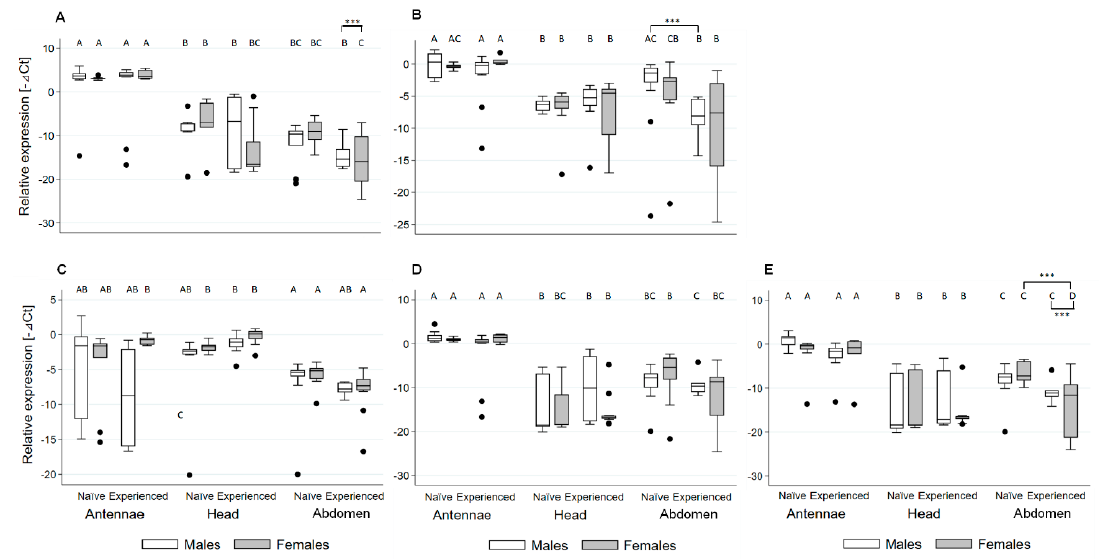
Figure 4. The relative expression pattern analysis ( − ∆ Ct) of six odorant receptor (OR) genes for samples of different sex (male and female), status (colony odor-experienced/-naïve), and body parts (antennae, heads, and abdomens) in SHBs. ( A – E ) shows, respectively, the relative expression patterns of OR genes coding proteins: OR coreceptor (ORco) (XP_019869252.1) and ORs (XP_019872736.1, XP_019869899.1, XP_019872939.1, and XP_019869900.1). Ct values reflecting target gene transcripts were subtracted from Ct values of reference gene AtumRp311 (( − Δ Ct) to show relative differences in gene expression. All analyses were performed using 15 biological replicates. Different capital letters above boxes indicate significant differences ( p < 0.001) determined by STATA 15 software (more details please see data analysis).